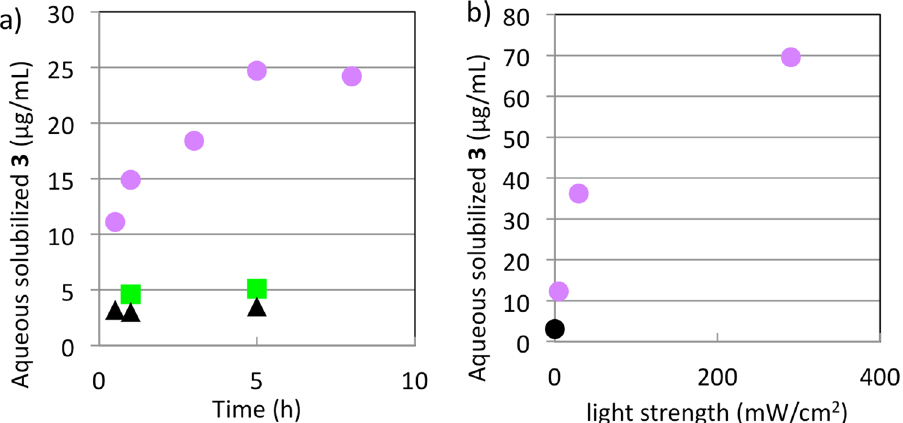
Figure 2. Aqueous solubilization of 3 . ( a ) Solubilization under UV irradiation (magenta circles), under visible light irradiation (green squares), and in the dark (black triangles) at 37 °C. UV irradiation was performed with a mercury lamp (0.5 mW/cm 2 ). ( b ) Solubilization of 3 under UV irradiation at various intensity levels. Sample irradiation was conducted using 365 nm LED light at 37 °C for 1 h.